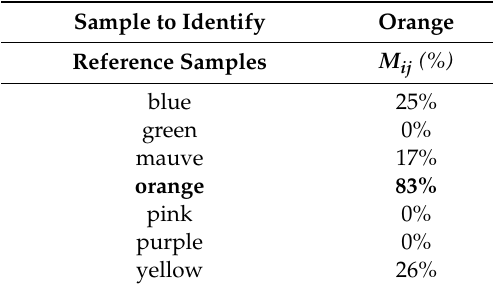
Table A6. Identification of a sample (orange paper) using the coloured paper CaliPhoto vector database. The best match is the orange paper, with a match percentage M = 83%. The second-best match occurs for the yellow paper, but the match percentage is only 26%.